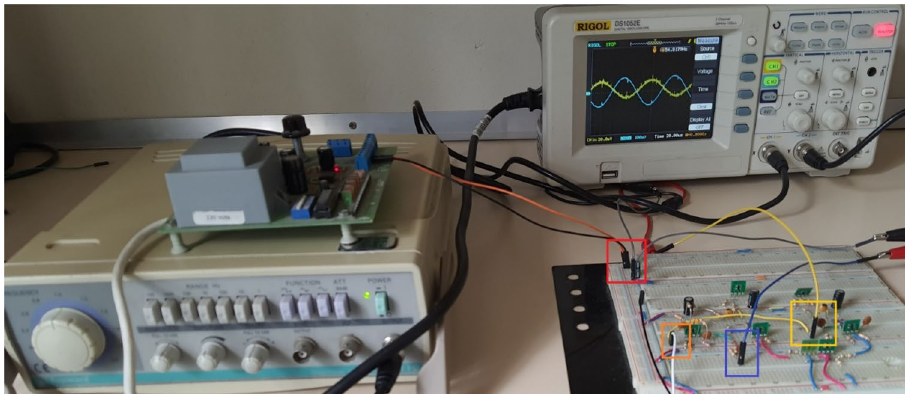
Fig. 11 Experimental setup showing power supply, func- tion generator with a proto-